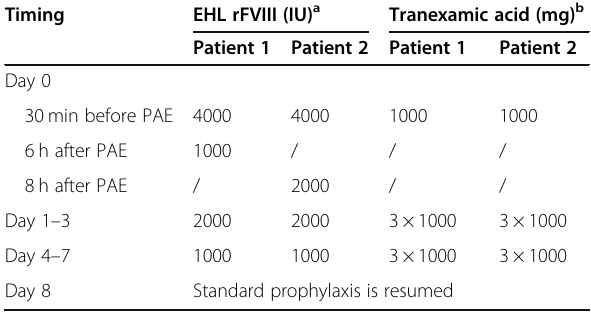
Table 1 Perioperative hemostasis regimens for both patients